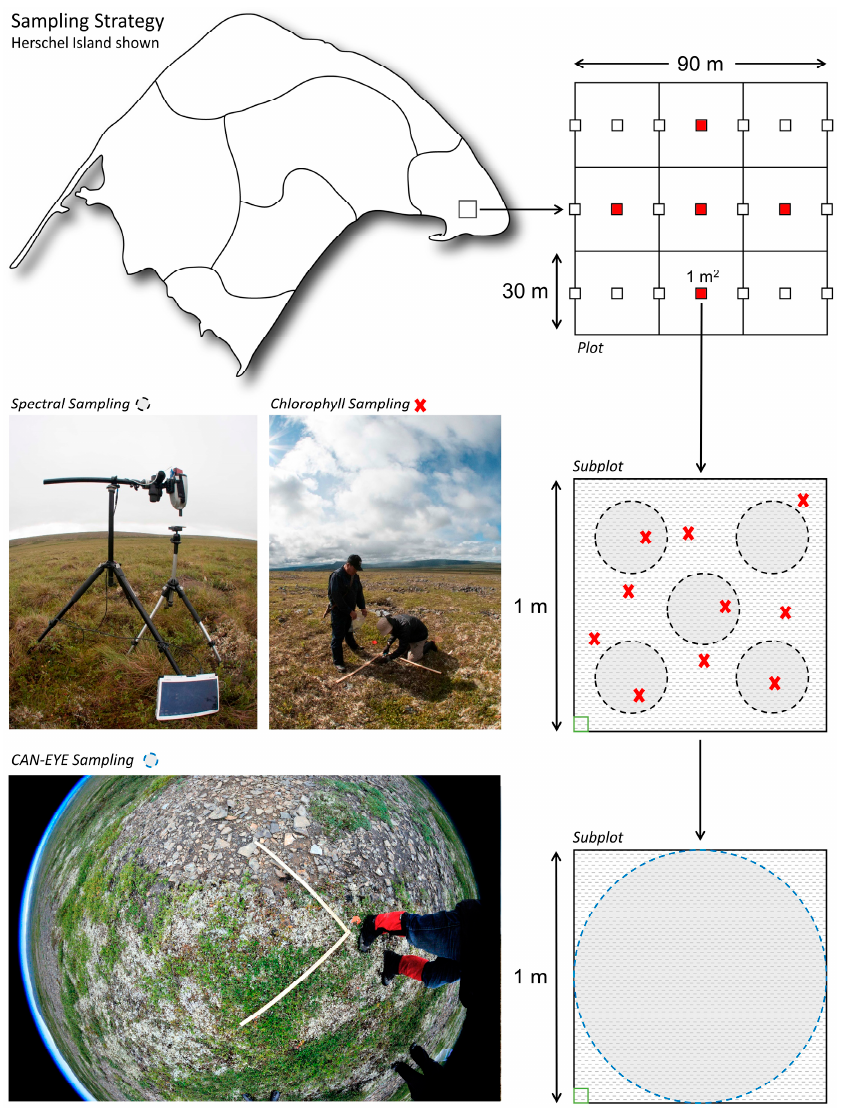
Figure 2. Field plot sampling design used for vegetation parameter and spectral measurements. The Herschel Island site is given as an example. Bottom left hemispherical photo shows a 1 m 2 subplot.